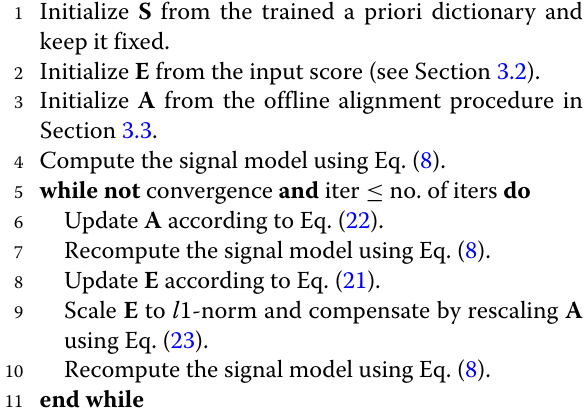
Algorithm 1 Offline signal factorization scheme